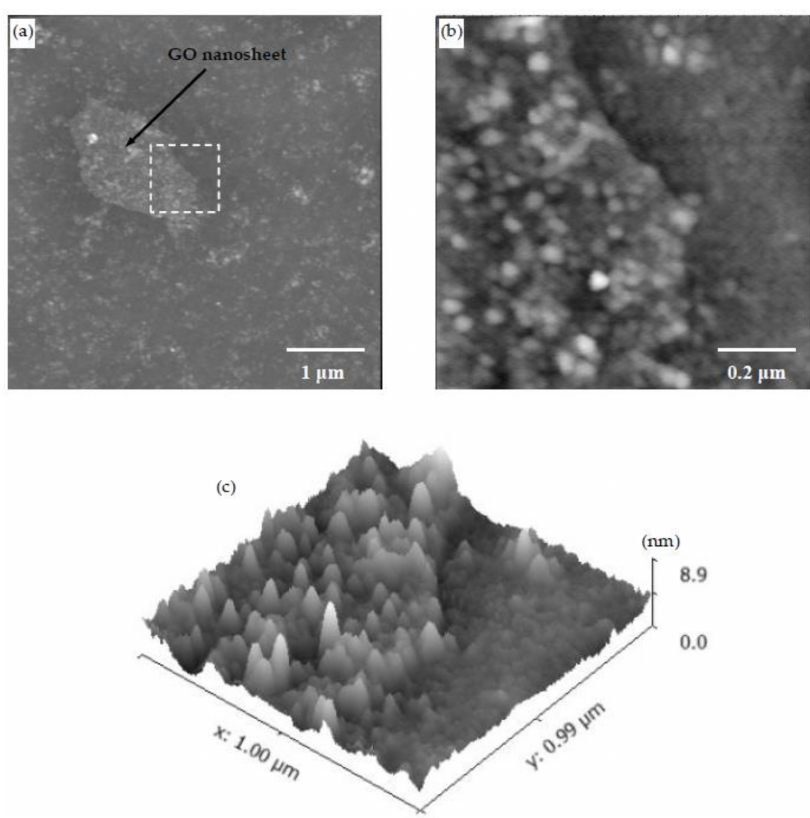
Figure 12. ( a ) AFM image showing a GO nanosheet in the PEI/PSS-CSH-GO sample made of one trilayer; ( b , c ) 2D and 3D higher magnification images of the area marked by a square in ( a ), respectively. A higher density of CSH particles is observed on the surface of GO.